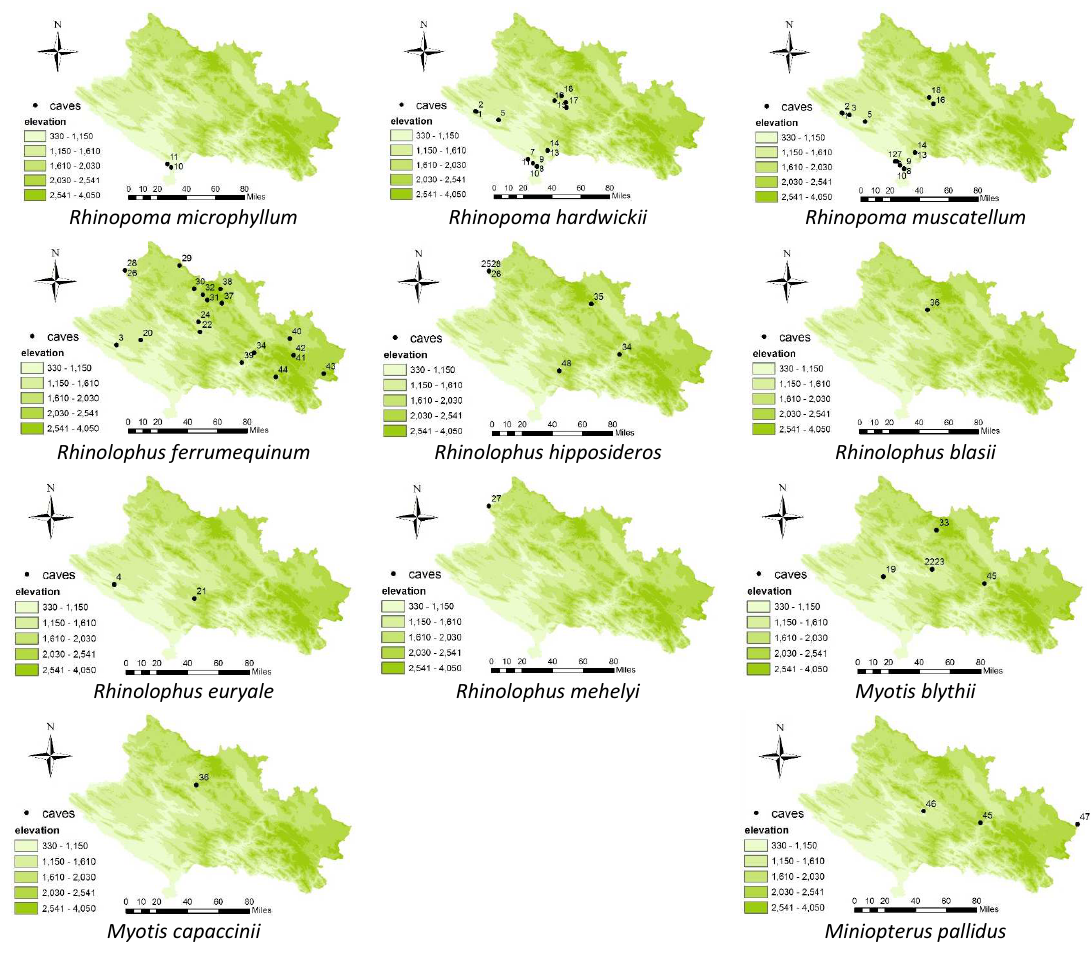
F IGURE 5. Separate maps of bat records for each